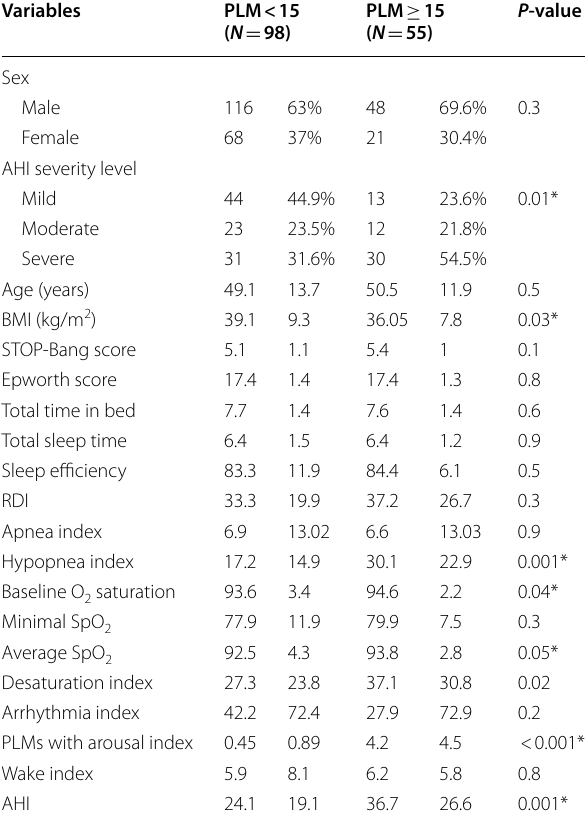
had non-significant higher mean RDI than non-PLM (37.2 26.7 vs 33.3 19.9 respectively). Also, the present ± ±